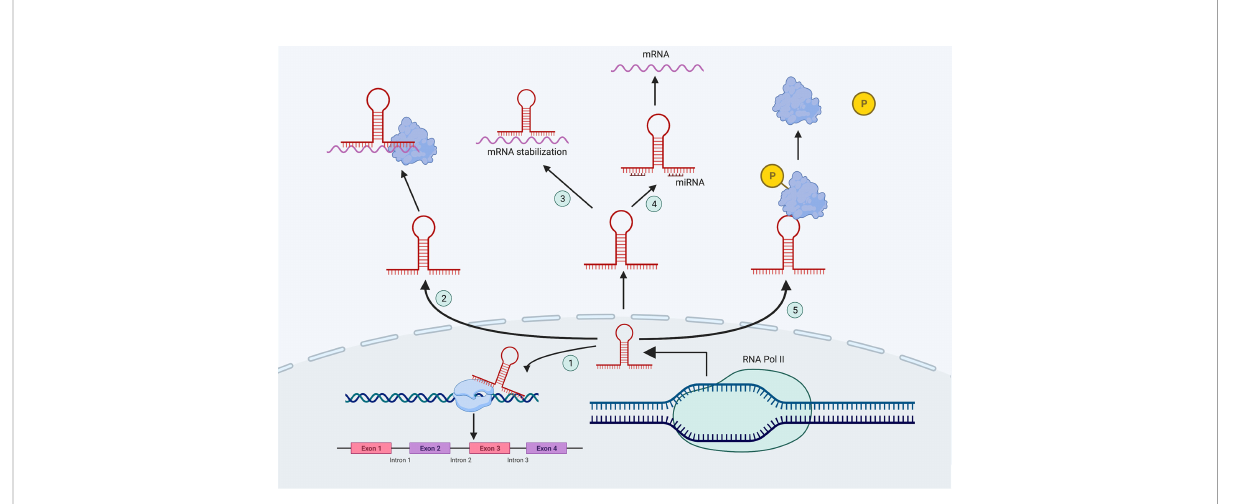
FIGURE 1 The mechanisms of lncRNAs. ① Molecular guide; ② Scaffolds; ③ Signals; ④ CeRNAs; ⑤ Molecular